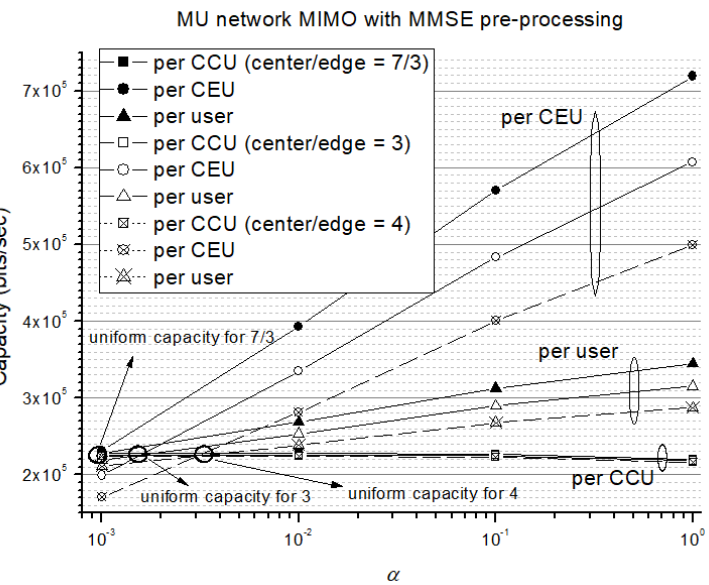
Figure 12. Capacity comparison between different values of center-edge area ratio for MU-network MIMO with MMSE joint preprocessing. Table 1. The distribution of the value of α